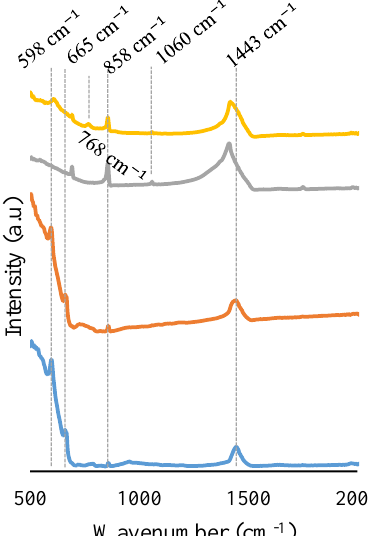
Figure 2. FT-IR spectra of BM-E, B0.7M-E, BF, and B0.7F-E catalysts.